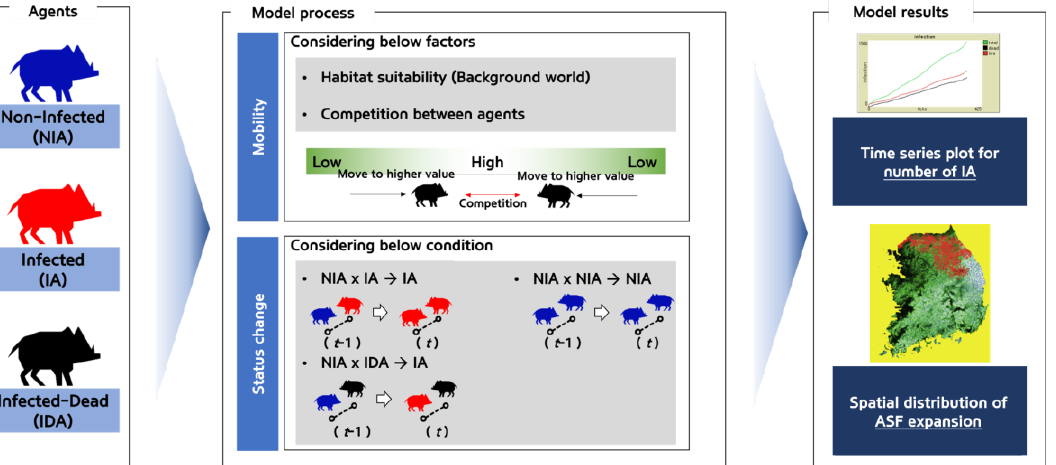
Figure 2. The model was designed to estimate ASF expansion based on agent mobility and status change (ASF infection)